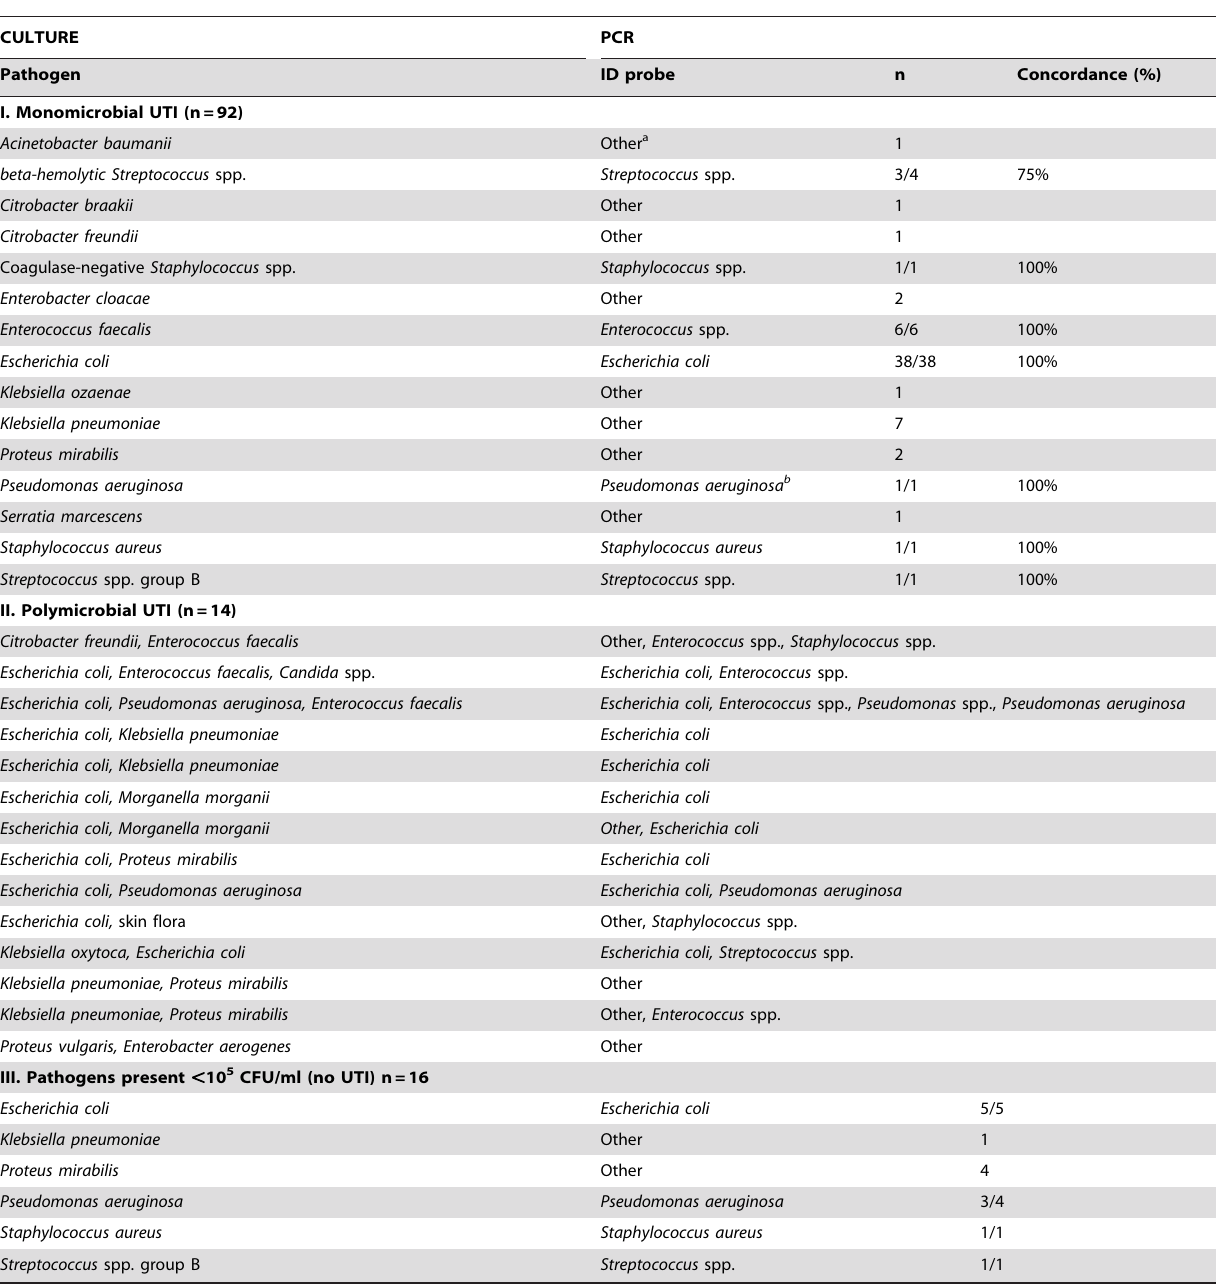
Table 2. Pathogen identification of the 122 growth-positive urine